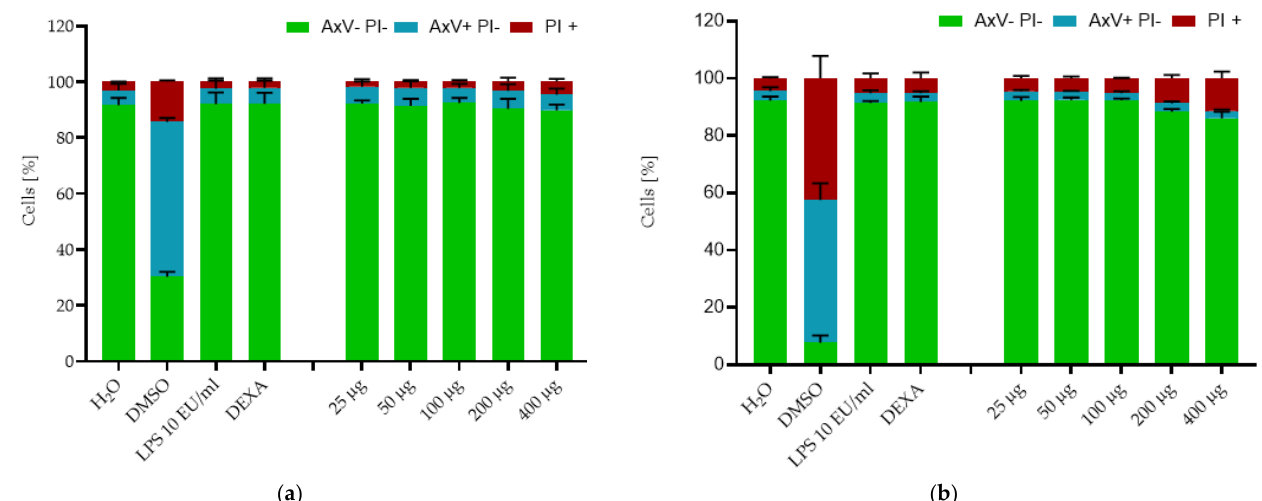
Figure 6. Effects of SPION HAp on the viability of THP-1 (ATCC ® TIB-202™). Cells were incubated with SPION HAp particle concentrations of 25 to 400 μg/mL and additional controls of H 2 O, DMSO 2%, dexamethasone (DEXA) 0.1 µM, and LPS. After ( a ) 24 and ( b ) 48 h of incubation. Each experiment was performed in triplicate. The mean values are shown with SD. Significance between treatment groups and control (AxV- PI-) at the respective time is indicated by asterisks: * p < 0.05. p values higher than 0.05 were assumed not significant (n.s.).